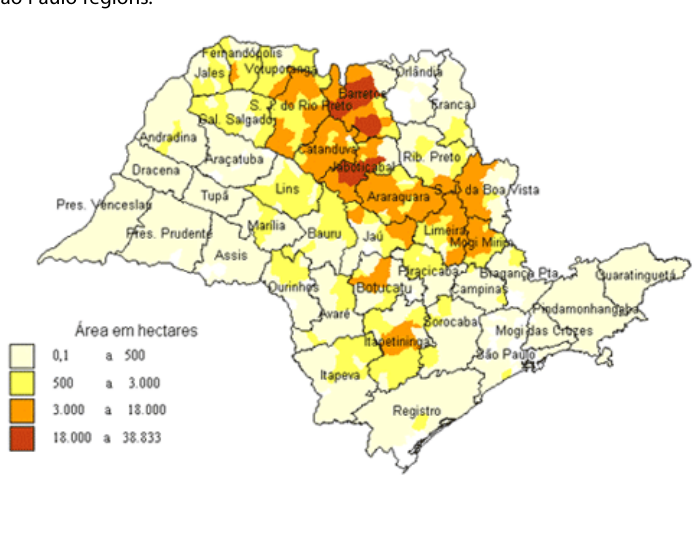
Figure 2. São Paulo